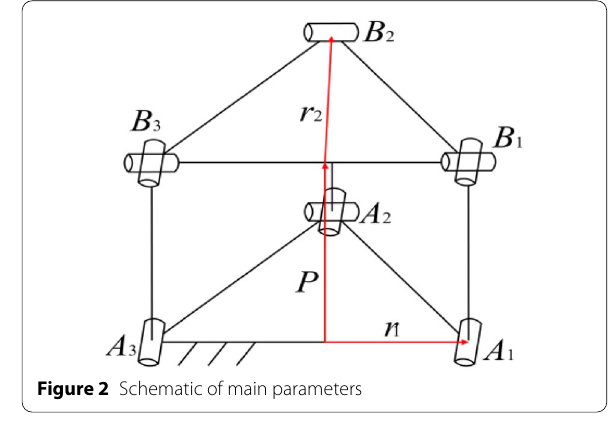
Figure 2 Schematic of main